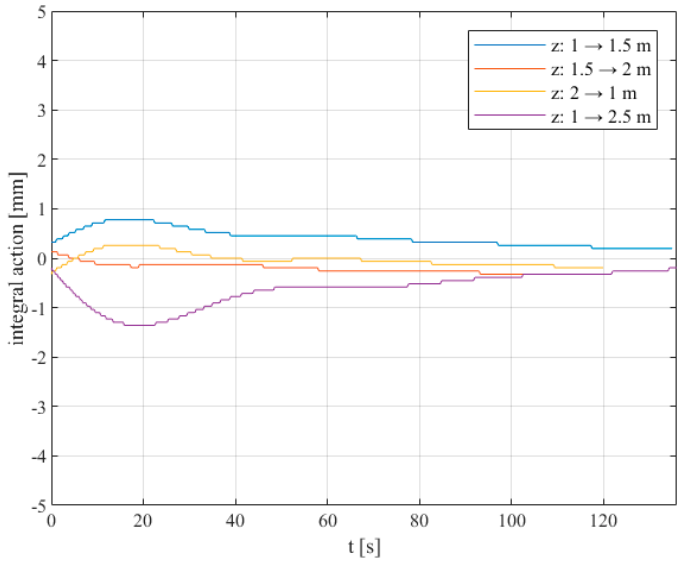
Figure 14. PID depth controller: integral action evolution over time of the trials shown in Figure 13.